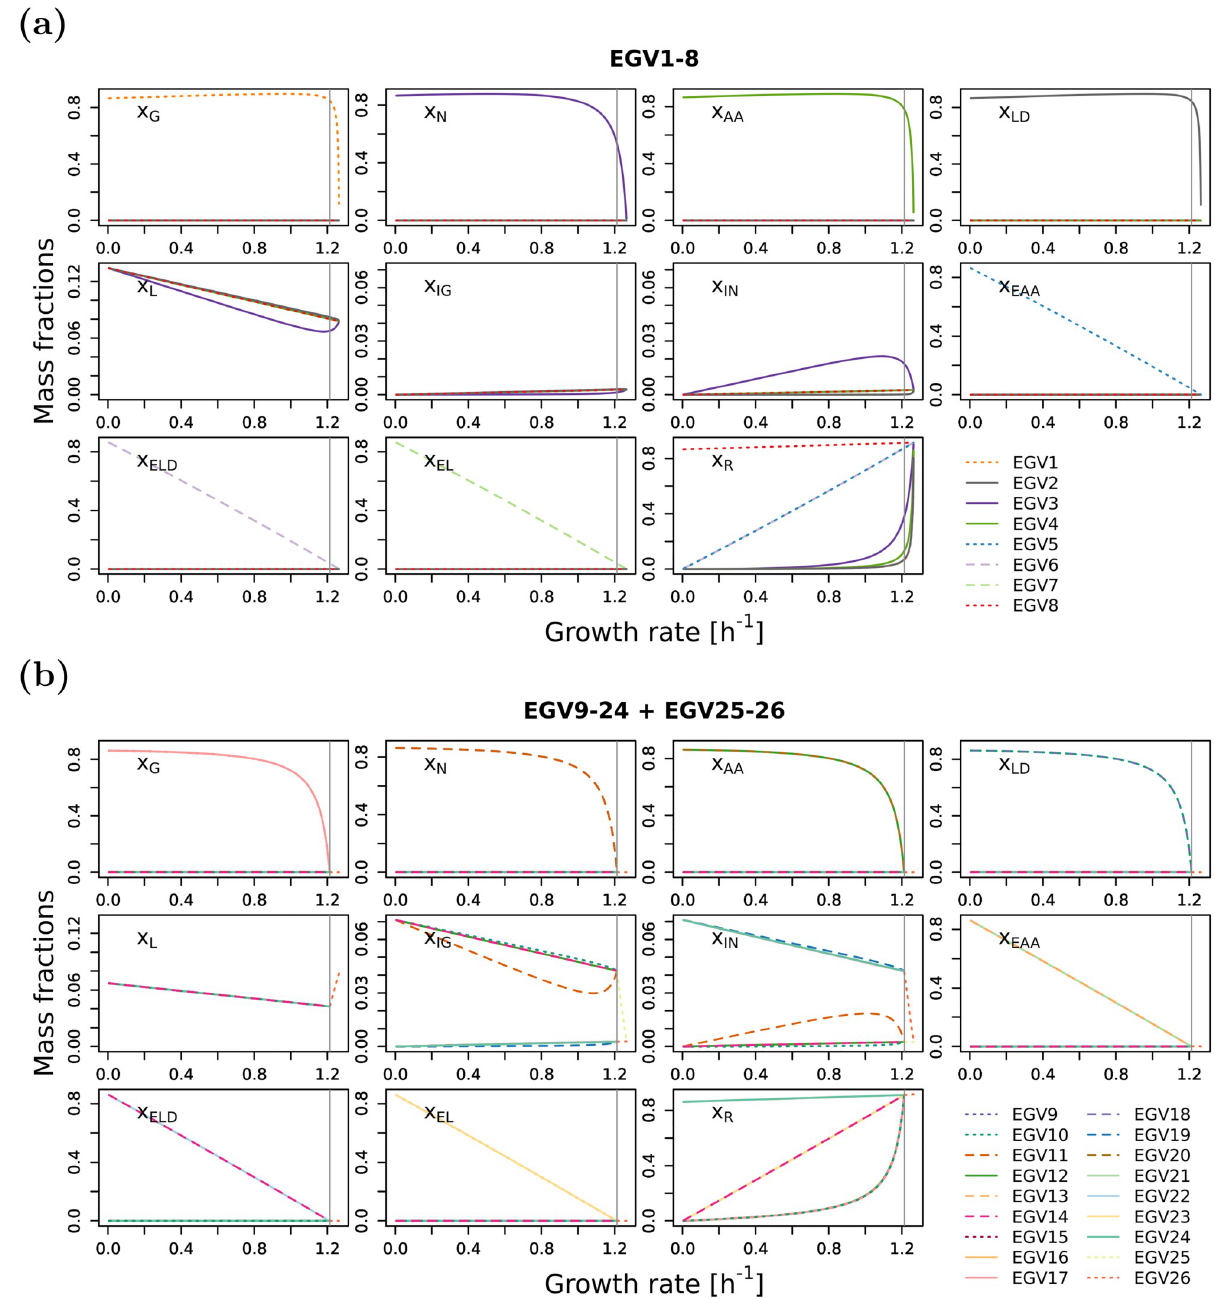
Fig 4. Mass fractions for (a) the 8 EGVs that exist for all growth rates and (b) the 16 EGVs that exist in regime L plus the 2 EGVs that exist in regime